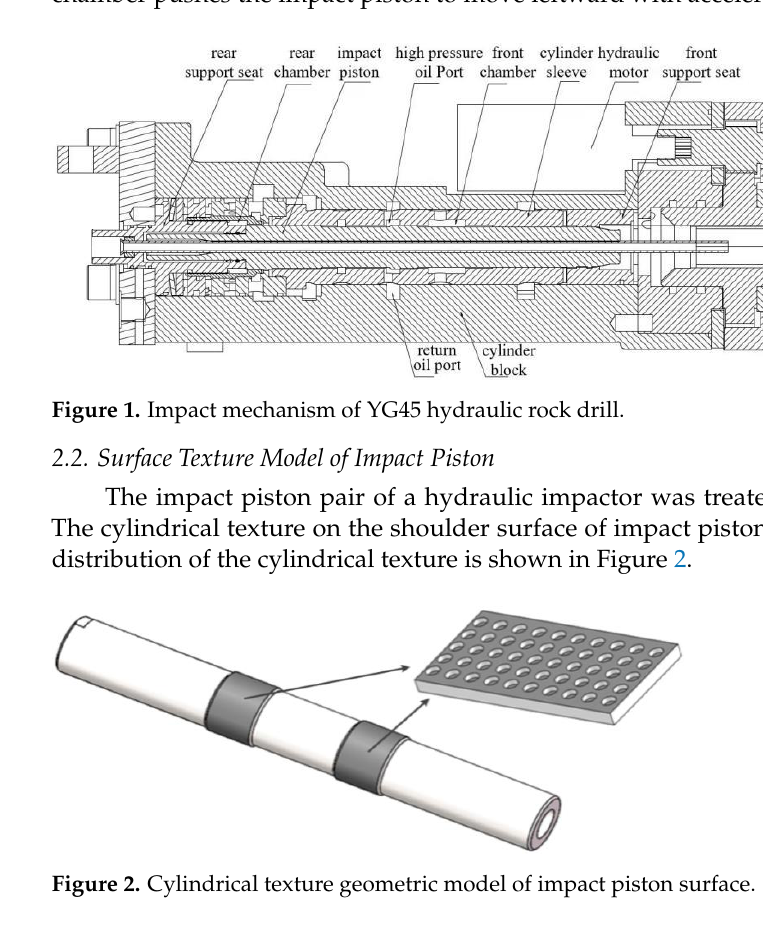
Figure 1. Impact mechanism of YG45 hydraulic rock drill.